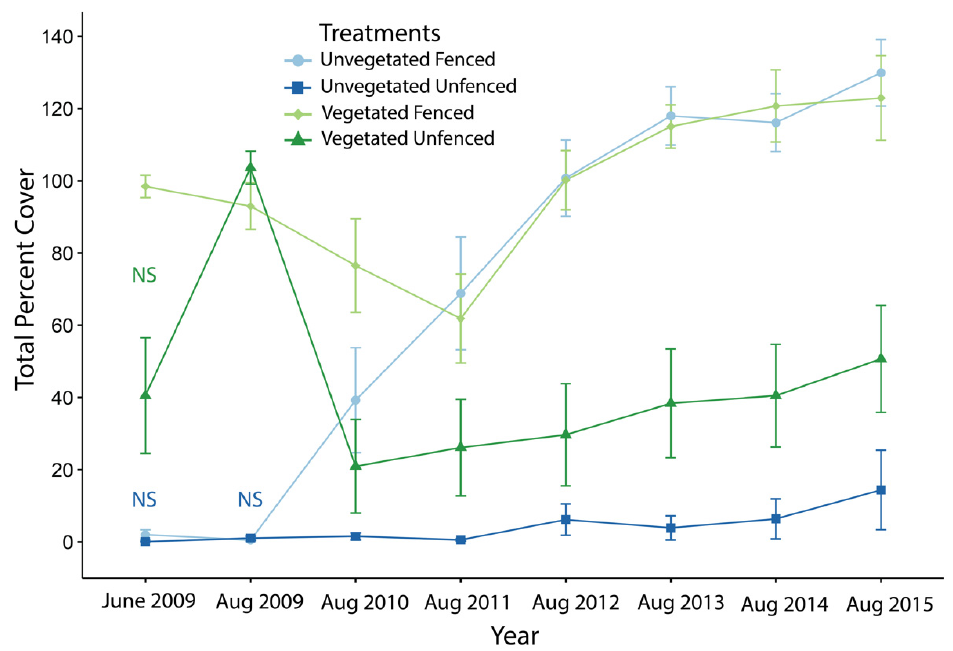
Figure 2. Total percent cover through time in fenced (lighter colors) and unfenced (darker colors) plots of initially vegetated (green) and initially unvegetated (blue) modules. June 2009 data are included as a baseline; all other data presented were collected in August to reflect that year’s growing season. Labels of “NS” indicate a non-significant difference between control and exclosure treatments on that sampling date, color-coded to indicate initially vegetated state; on all other dates, differences were statistically significant. t -test statistics are reported in Table S2. Error bars are standard